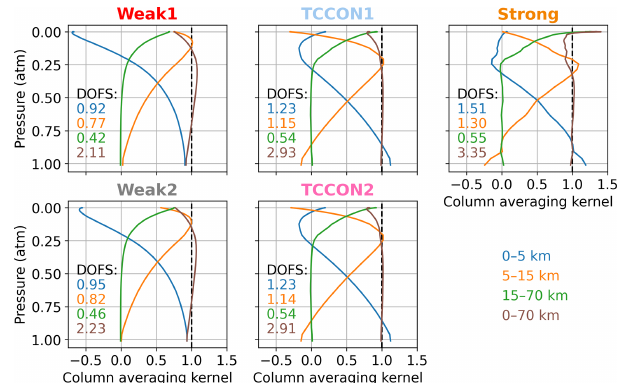
Figure 13. Sum of the rows of the partial column averaging kernel matrix over different altitude ranges as indicated by the legend, for each of the five CO 2 windows. The sum between 0–70km is the total column averaging kernel. The numbers in each panel are the DOFs corresponding to each of the altitude